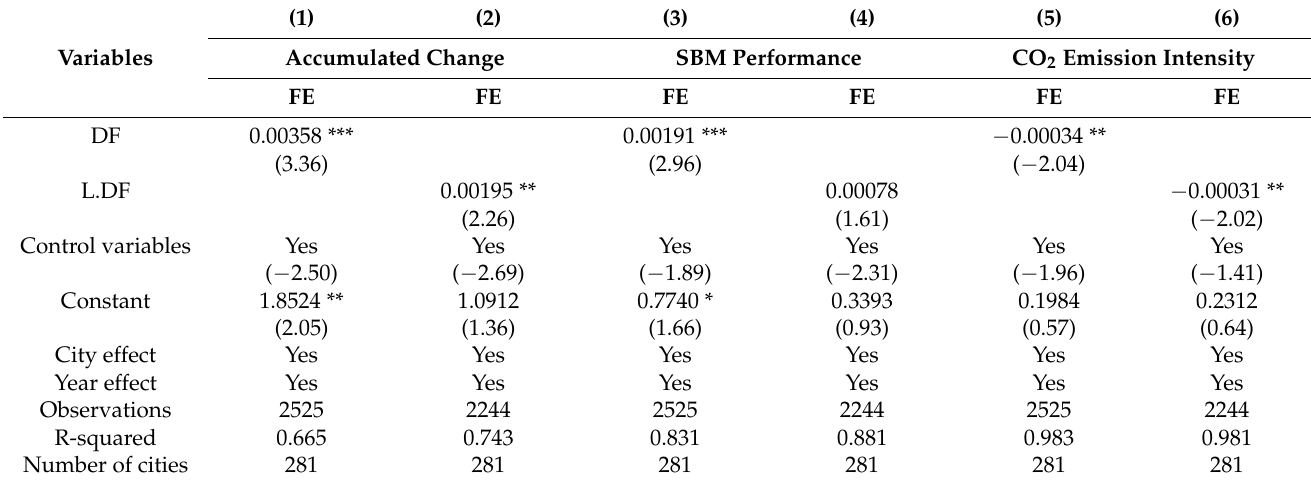
Table 6. Robustness: alternative indicator of carbon emission